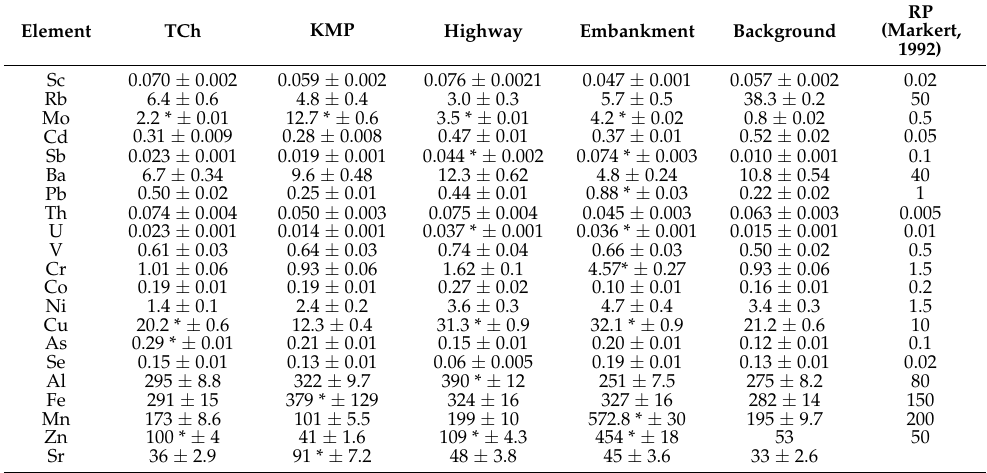
Table 7. Bioaccumulation of toxic elements by Echinochloa frumentacea grown on soils with polyele- ment anomalies (vegetation period 1.5 months) (average data for ICP-MS and INAA),